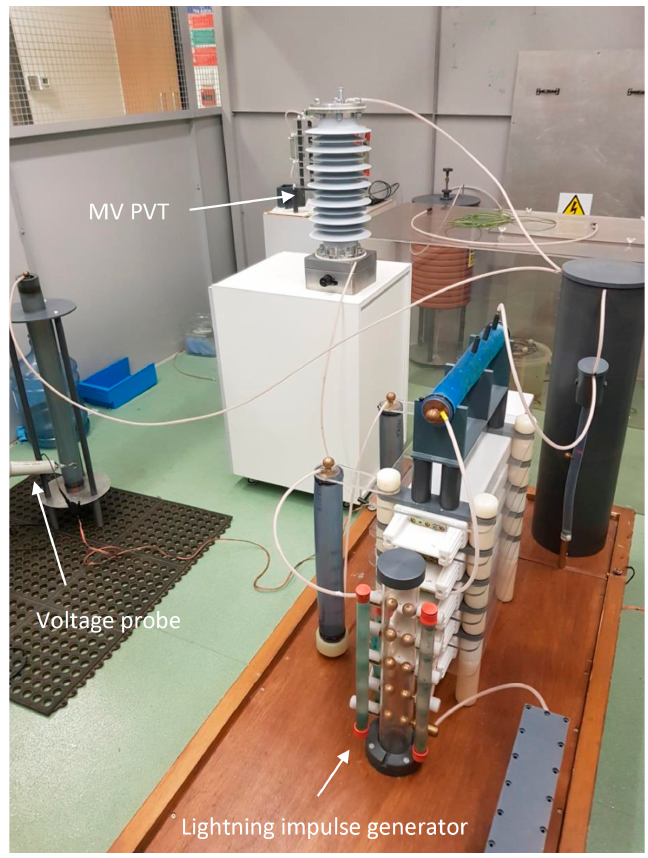
Figure 24. Lightning impulse voltage tests.